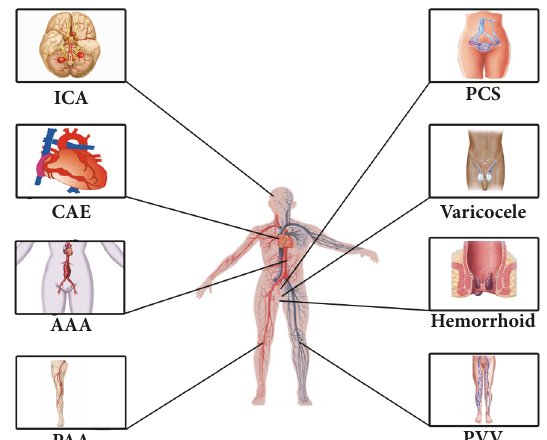
Figure 1: Arterial and venous dilating vascular diseases. AAA: abdominal aortic aneurysm, CAE: coronary artery ectasia, ICA: intracranial aneurysm, PAA: peripheral arterial aneurysm, PCS: pelvic congestion syndrome, PVV: peripheral varicose